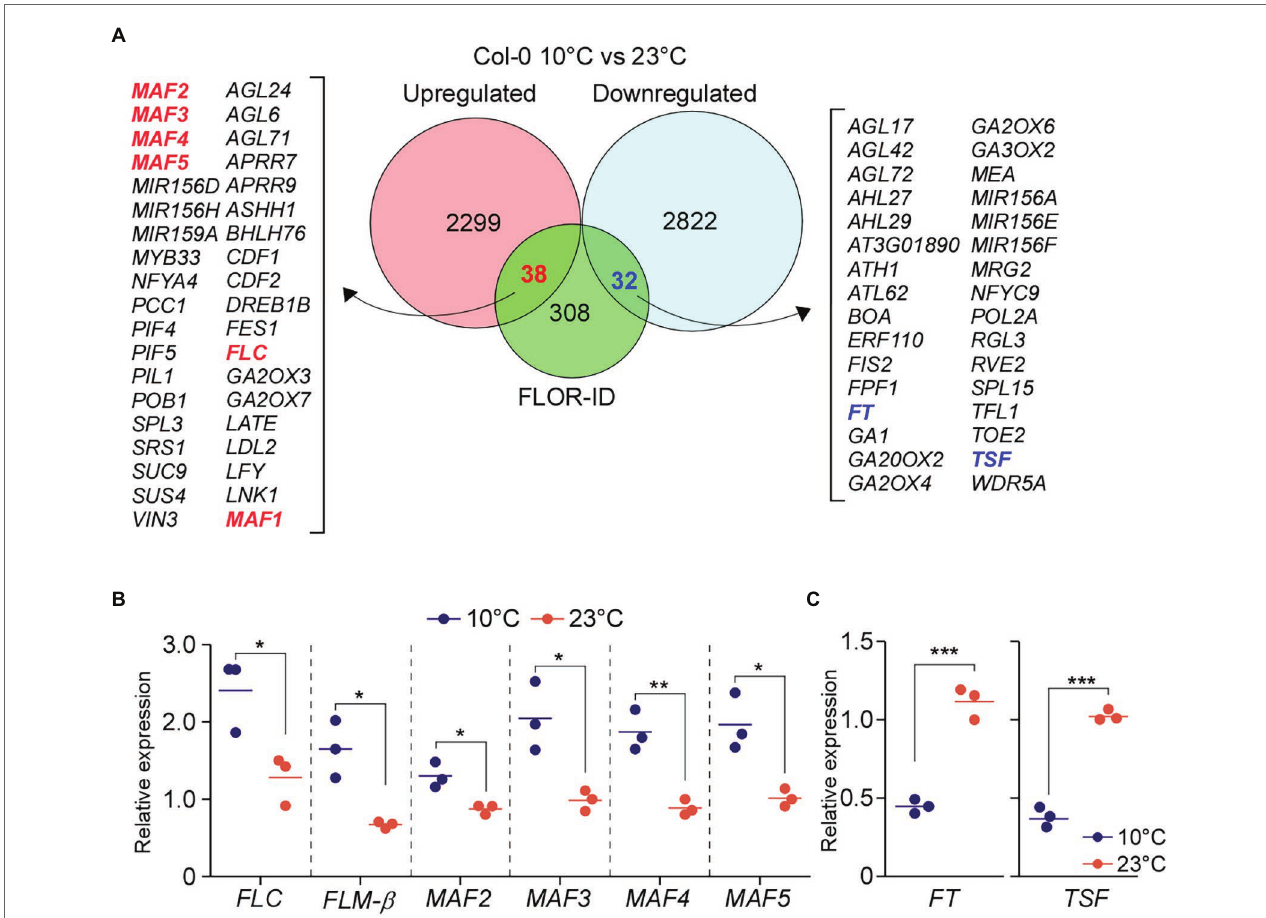
FIGURE 5 | Low temperature induces the expression of FLC and FLC -clade genes. (A) Differentially expressed genes (DEGs) between wild-type (Col-0) seedlings grown at 10 and 23 ° C under LD conditions. (B,C) Relative mRNA levels of FLC and FLC -clade genes (B) and FT (C) at 10 ° C under LD conditions. One-way ANOVA followed by Dunnett’s multiple comparison tests were performed to test the statistical significance. * p < 0.05; ** p < 0.01; and *** p ≤